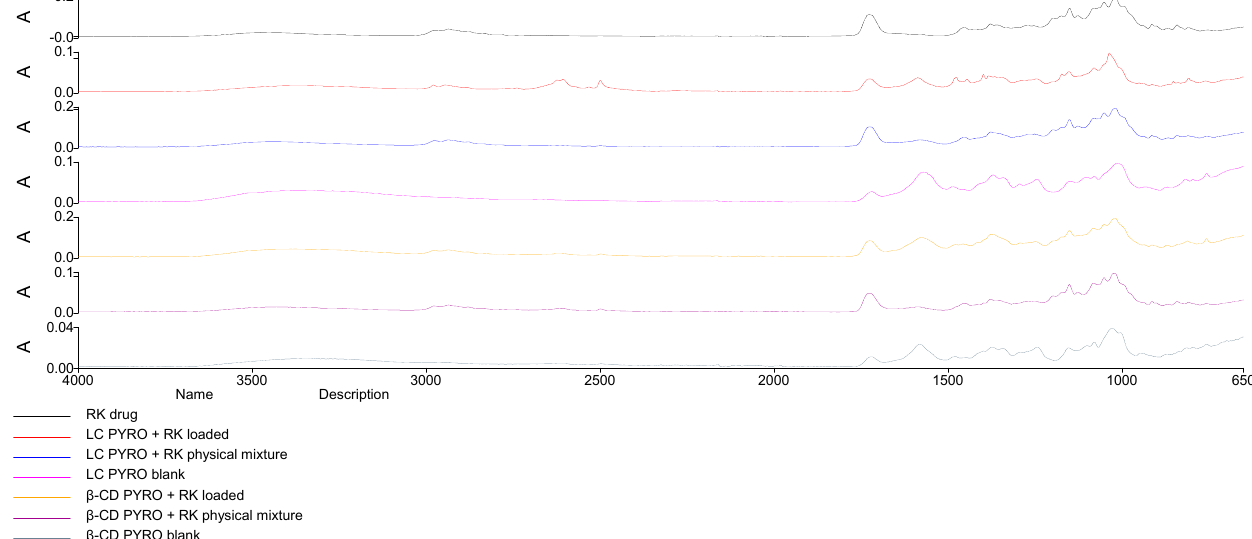
Table 4. Swelling degree of nanohydrogels at different pH levels. Sample